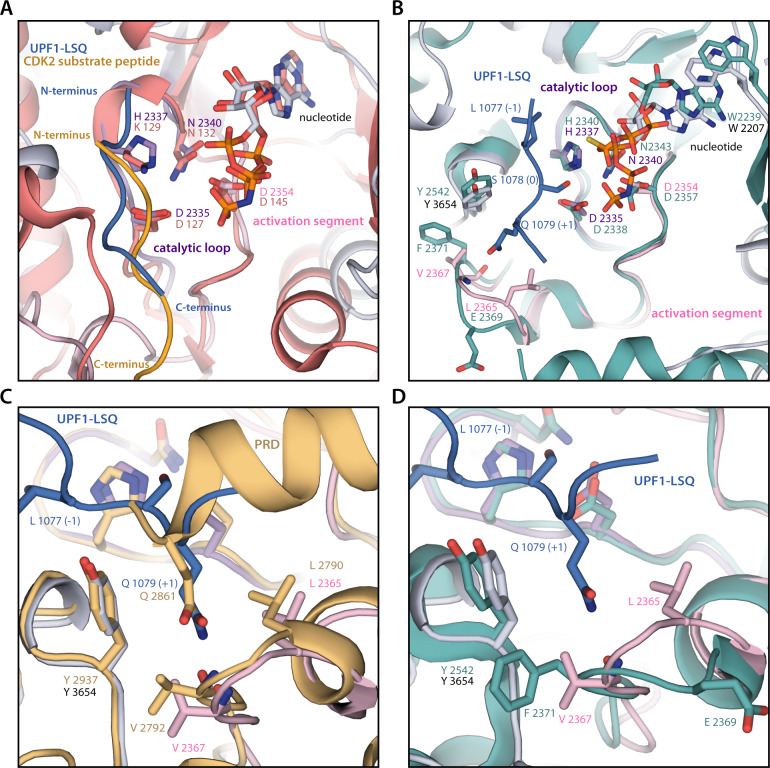
Comparison of SMG1 substrate-bound active site to other protein kinases.(A) Superposition of substrate-bound SMG1 active site with substrate-bound CDK2 active site (PDB ID, 3QHW). SMG1 catalytic loop is colored in magenta, SMG1 activation segment is in pink, CDK2 is shown in salmon and the CDK2 substrate peptide is in orange. Directionality of the substrates and important catalytic residues are indicated and colored as described above. P-loops were omitted for clarity. The SMG1 kinase contains features that have previously been associated with a model preferring the presence of a ‘dissociative’ transition state, such as a positive charge closely involved in β-phosphate coordination, namely K2155 (residue not shown) (Wang and Cole, 2014). (B) Superposition of substrate-bound SMG1 active site with nucleotide-bound mTOR active site (PDB ID, 4JSP). SMG1 active site is colored as described in panel A and mTOR is in green. Important active site residues are indicated. P-loops were omitted for clarity. (C) Close-up of the active site hydrophobic cage after superposing the model of the substrate-bound SMG1 active site with Chaetomium thermophilum Tel1ATM (PDB ID, 6SKY). SMG1 active site is colored as described in panel A and CtTel1ATM is colored in light orange. Key residues are indicated. (D) Close-up of the active site hydrophobic cage based on the superposition of SMG1 and mTOR shown in B. Color scheme as in B and important residues are indicated. View is similar to C.